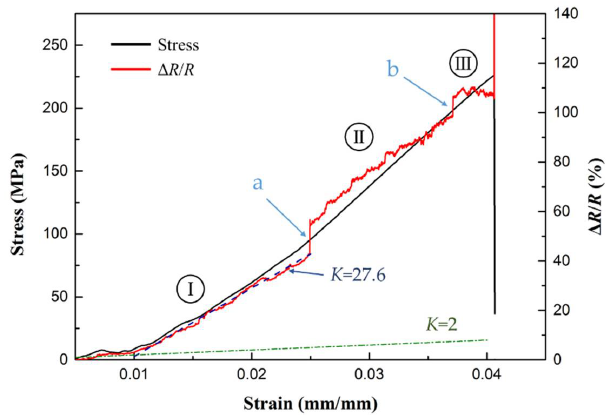
Figure 7. Stress and resistance change ratio of gNano-NSS under quasi-static strain.